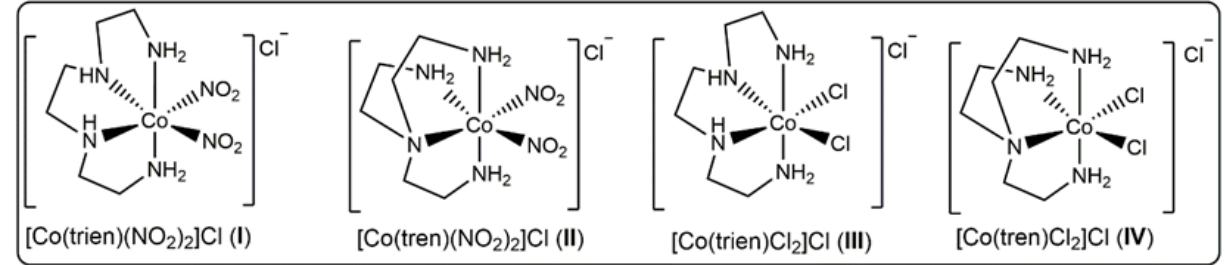
Figure 1. Structures of the complexes under study .